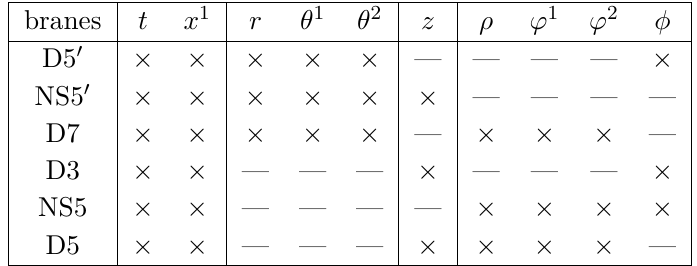
Table 4 . Brane picture underlying the intersection of the D5 0 -NS5 0 -D7 branes depicted in table 3 with extra D3-NS5-D5 branes. The system is BPS / 8